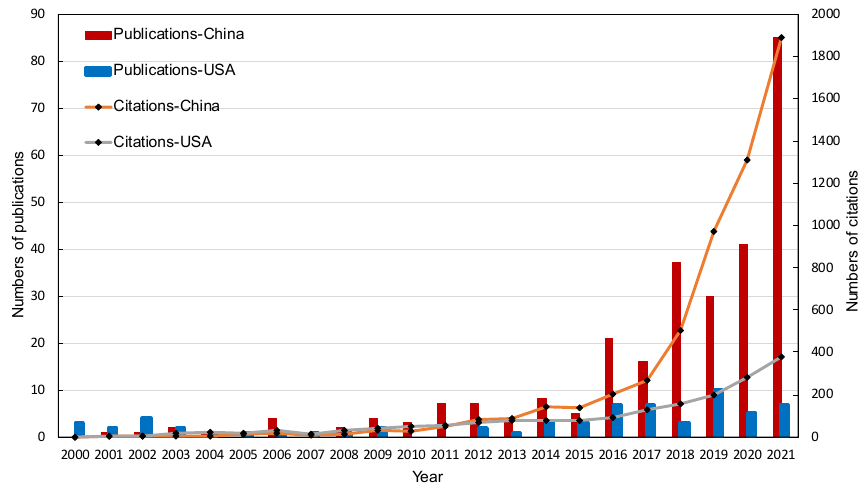
Figure 3 depicts a comparison of publication volume and annual citations between China and the USA over time (the top two countries in publication volume). The number of publications and citations in both countries did not alter significantly in the early 21st century when they were at a low point. It did not considerably increase until after 2015. In the last 5 years, the citations of China have increased proportionately and reached a new high of 1890 in 2021 (85 papers), indicating the expanding worldwide importance of China, while the USA has gradually climbed, reaching a maximum of 380 in 2021 (7 Papers). This phenomenon also demonstrates that as civilization has progressed, solid waste has received more attention.